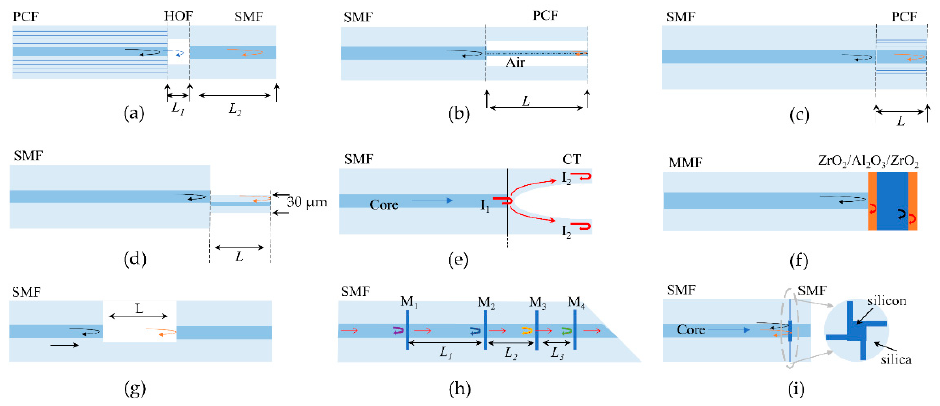
Figure 6. Typical types of FPI sensors for high-temperature measurements realized with splicing